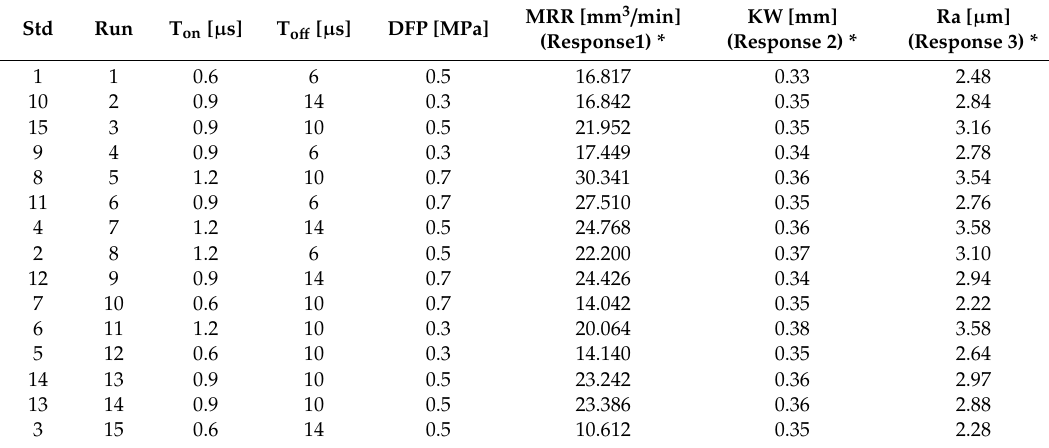
* Averaged values of measurements (for KW and Ra), or averaged calculated values for